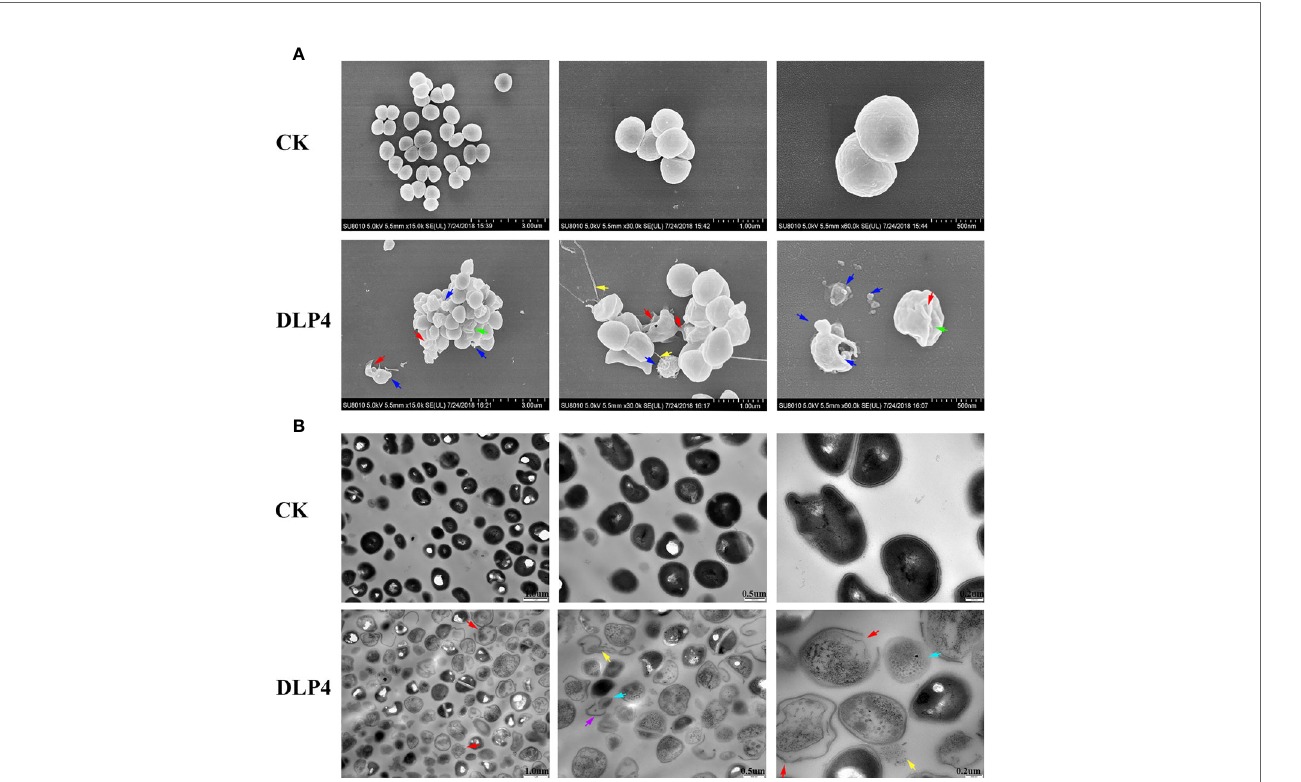
FIGURE 4 | Observation of the effect of DLP4 on the cell membrane and morphology of S. hyicus ACCC 61734. (A) SEM images of S. hyicus ACCC 61734 treated with 4× MIC DLP4 for 2 h. (B) TEM images of S. hyicus ACCC 61734 treated with 4× MIC DLP4 for 2 h. The arrows indicate speci fi c symptoms. Red arrow: membrane perforation; blue arrow: membrane vesicles; yellow arrow: leakage of cytosol; green arrow: cell shrinkage; purple arrow: cell wall; cyan arrow: ghost cell.